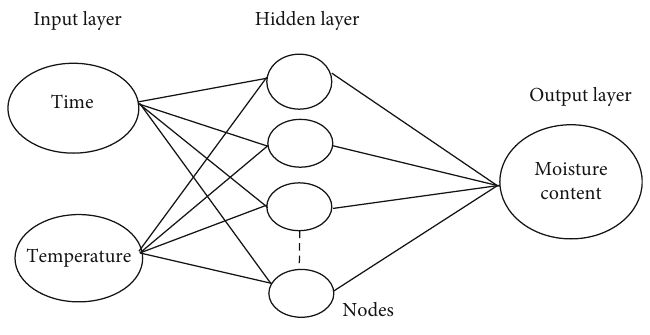
Figure 5: ANN structure